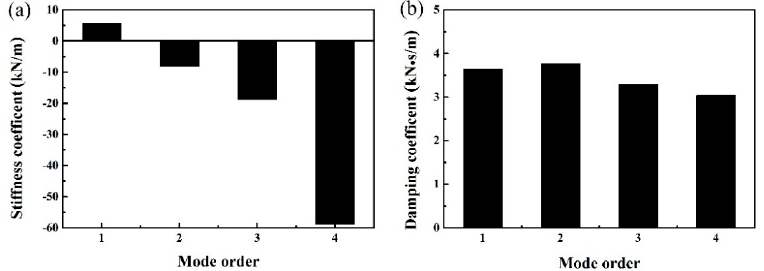
Figure 16. Identified damping coefficients and stiffness coefficients of the self-powered MR damper. ( a ) Identified stiffness coefficients; ( b ) Identified damping coefficients .